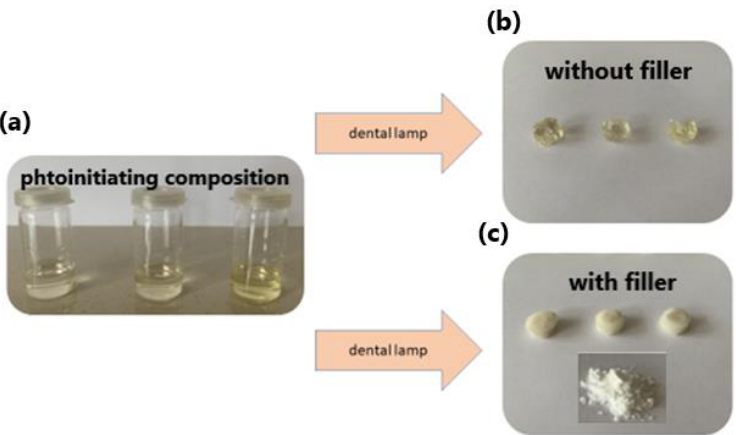
Figure 9. Comparison of the acrylate monomer polymerization photoinitiated by couples consisting of tested dyes and diMPhTAA co-initiator in the presence and absence of a glass ionomer, a filler for dental fillings. The co-initiator concentration was 0.1 M, optical density of the sensitizers was 1.8 at an excitation wavelength (400 nm), light intensity of dental lamp was 30 mW/cm 2 . ( a ) Photoinitiating compositions containing AN2 (left), AN3 (center) and AN8 (right) sensitizers, respectively, ( b ) glazes obtained upon irradiation of the photoinitiating compositions without a dental filler and ( c ) dental fillings resulting from polymerization of the photoinitiating compositions containing a filler.